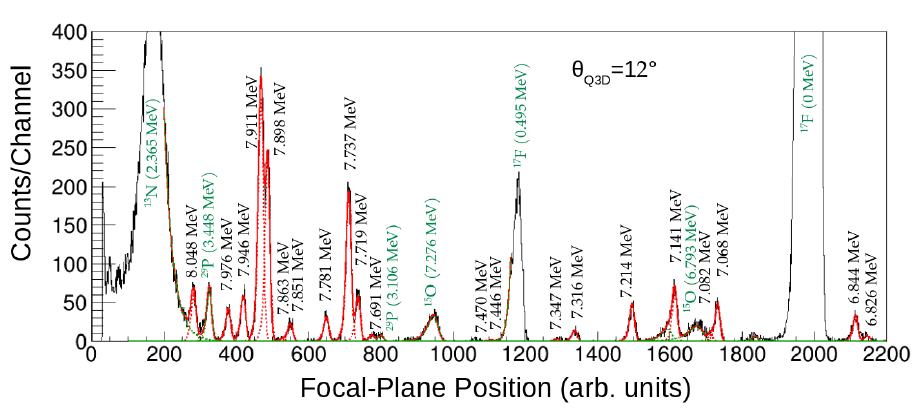
Figure 1. (Color online) Deuteron magnetic rigidity spectrum at θ lab = 12°. Excitation energies in = 6 . 8 MeV and 8 . 1 MeV are covered and are reported for each state. The best fit is 31 P between E x shown as a solid line, while the individual contributions are in red / green dashed lines for 31 P states and contaminant peaks,